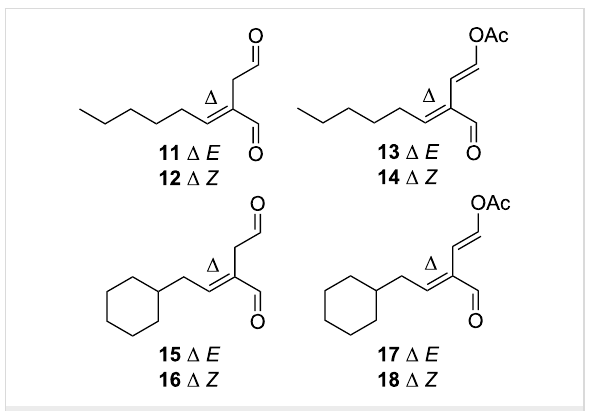
Figure 2: Target onchidal model compounds 11 – 18